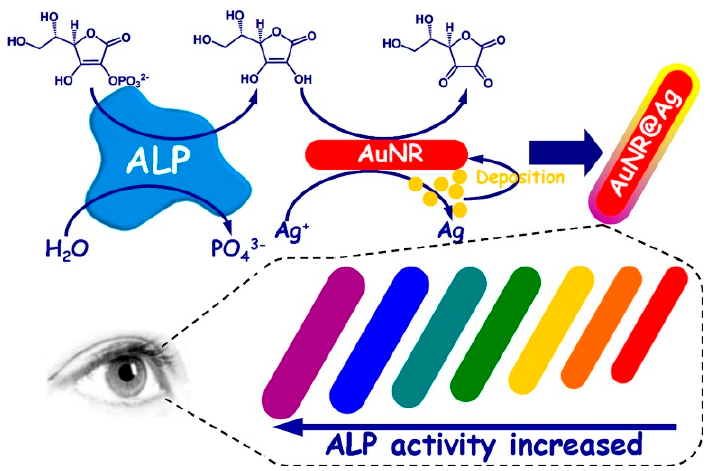
Figure 12. The schematic illustration of the colorimetric sensing of phosphatase activity based on enzymatic reaction-aided silver deposition onto AuNR to generate different color changes. Reproduced with permission from Reference [121]. American Chemical Society, 2014.